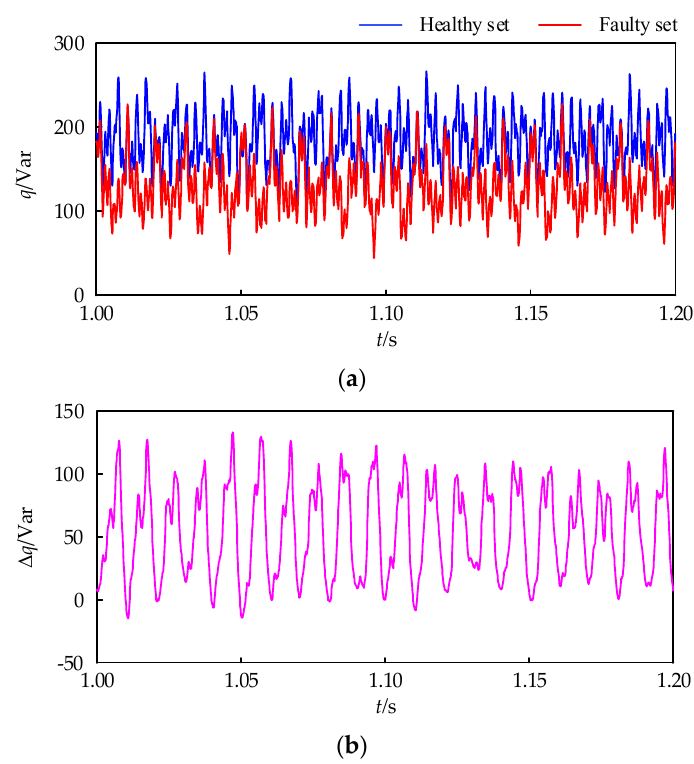
Figure 17. The experimental waveforms in 10 cycles: ( a ) q ; ( b ) Δ q .